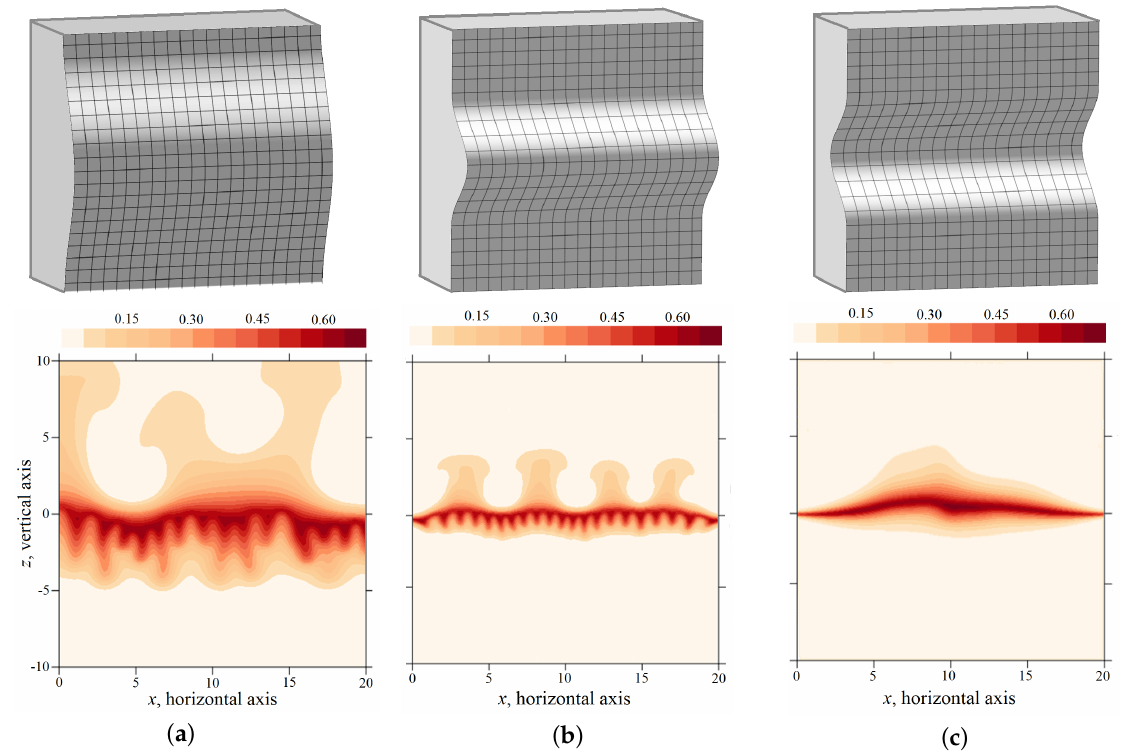
Figure 5. Evolution of the salt concentration (lower row) in a continuous-flow reactor real-time controlled by the deviations of the wide walls from the perfectly planar form (upper row). The frames ( a – c ) from left to right correspond to times t = 0.05,0.5,2 respectively.